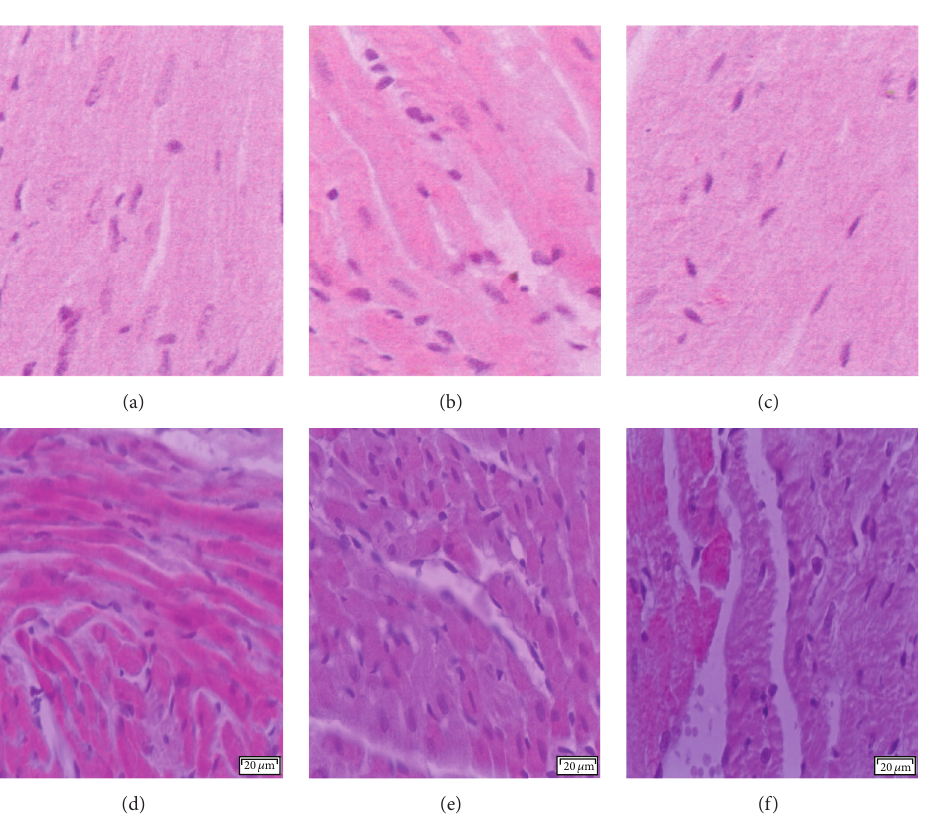
Figure 2: Photomicrography of COX-2 immunostaining in the studied different animal groups. (a), (b), and (c) represent minimal expression sections from the control, metformin, and sitagliptin groups, respectively. (d) represents high COX-2 expression found in the DOX group. (e) and (f) represent significantly lower COX-2 expression found in the metformin/DOX and sitagliptin/DOX groups, respectively, as compared to (d). DAB was used as a chromogen and haematoxylin as nuclear and counter stain. Magnification used is